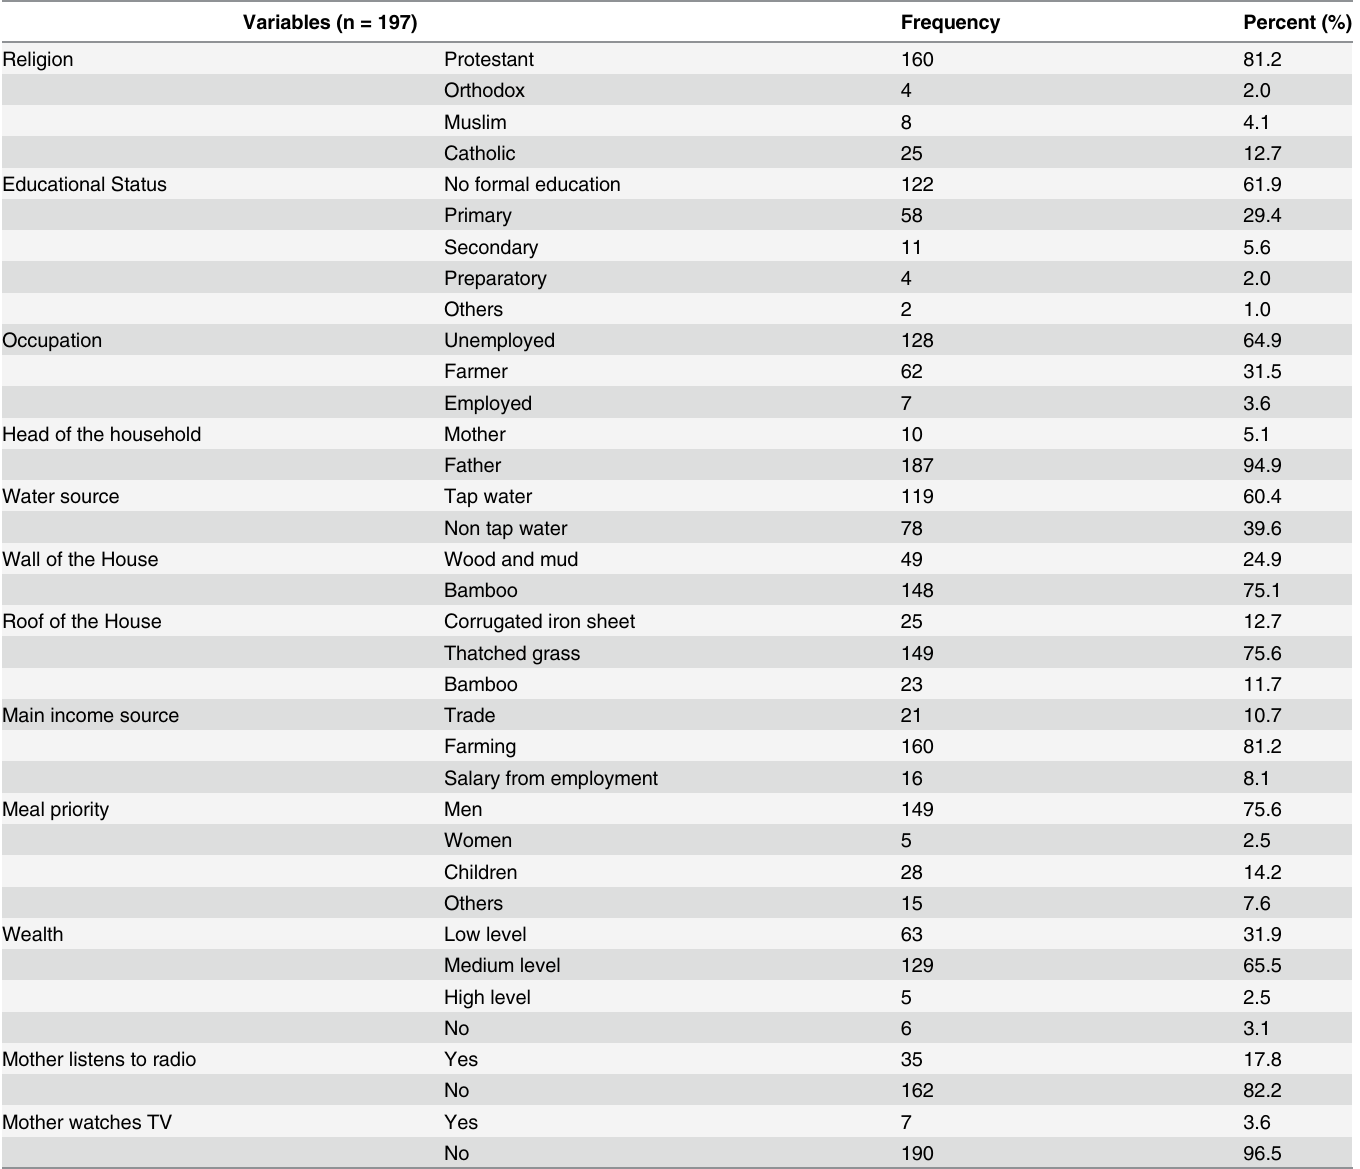
Table 1. Socio demographic and household